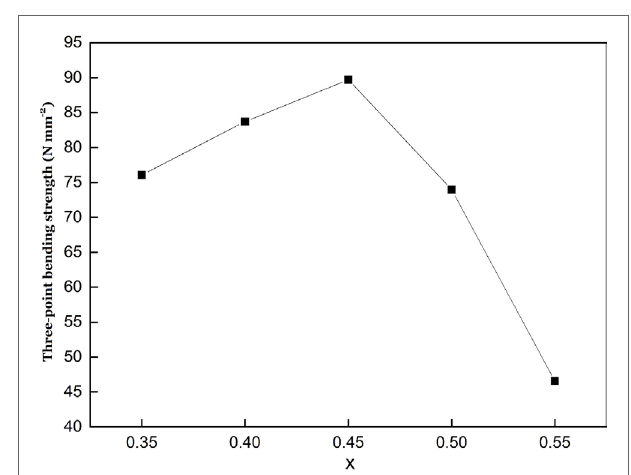
FigUre 8 | Temperature dependence of the electrical conductivity of li 1.45 al 0.45 ge 0.2 Ti 1.35 (PO 4 ) 3